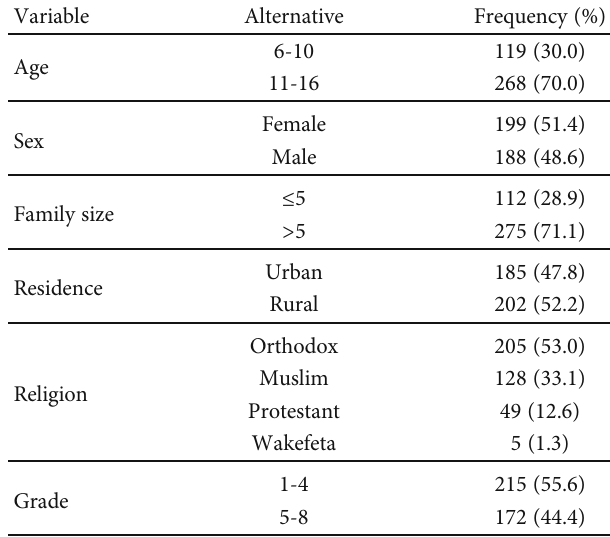
Table 1: Sociodemographic characteristics of the study participants, among school-age children at Goro Elementary School, Southwest Ethiopia,